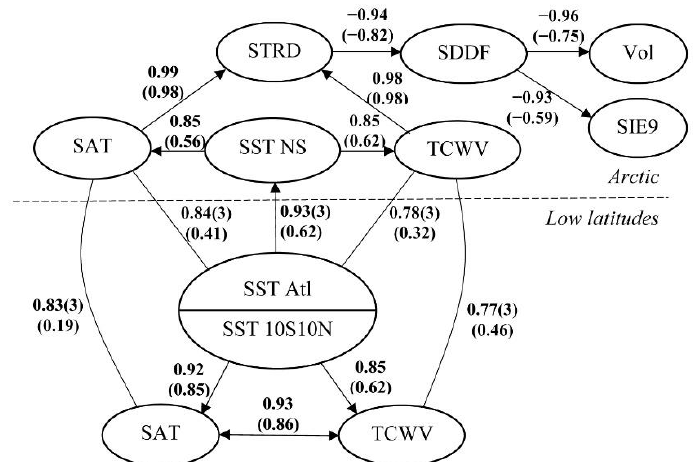
Figure 9. Graph of correlations relating the rise of SST at low latitudes and declines in maximum sea ice in the Arctic. In brackets, there is the coefficient between the series with the removed trend. The parameters of atmosphere and ocean are indicated in the ellipses on the scheme.